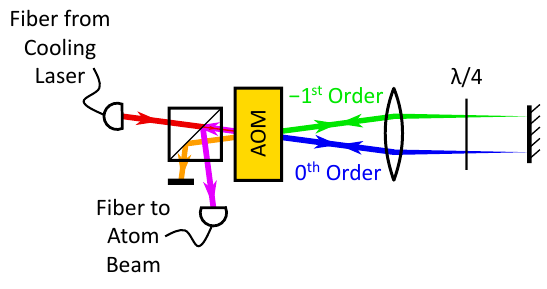
Figure 5. The optical setup used to create the light for optical pumping and atom beam switching. Input light, at frequency f 0 , from the cooling laser (red) passed through an AOM being driven at f RF , producing 0-order (blue) and − 1-order (green) output beams. These were retroreflected in a double-pass cat’s eye setup, without the usual iris blocking the 0-order beam. The result was that the output mode we wished to use (magenta) contained two frequency components—one from light that was shifted down in frequency on both passes (at frequency f 0 − 2 × f RF ), and the other from light that was not shifted during either pass (at frequency f 0 ). The unwanted second-pass output also contained two frequencies that were not of use to our experiment (at frequency f 0 − 1 × f RF and f 0 + 1 × f RF ), which we blocked with an iris. A λ /4 waveplate in the retroreflection arm, along with a polarizing beamplitting cube on the input side of the AOM, was used to spatially separate the input beam from the output beam of